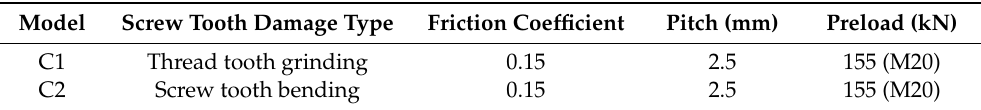
Table 2. Screw tooth deformation simulation